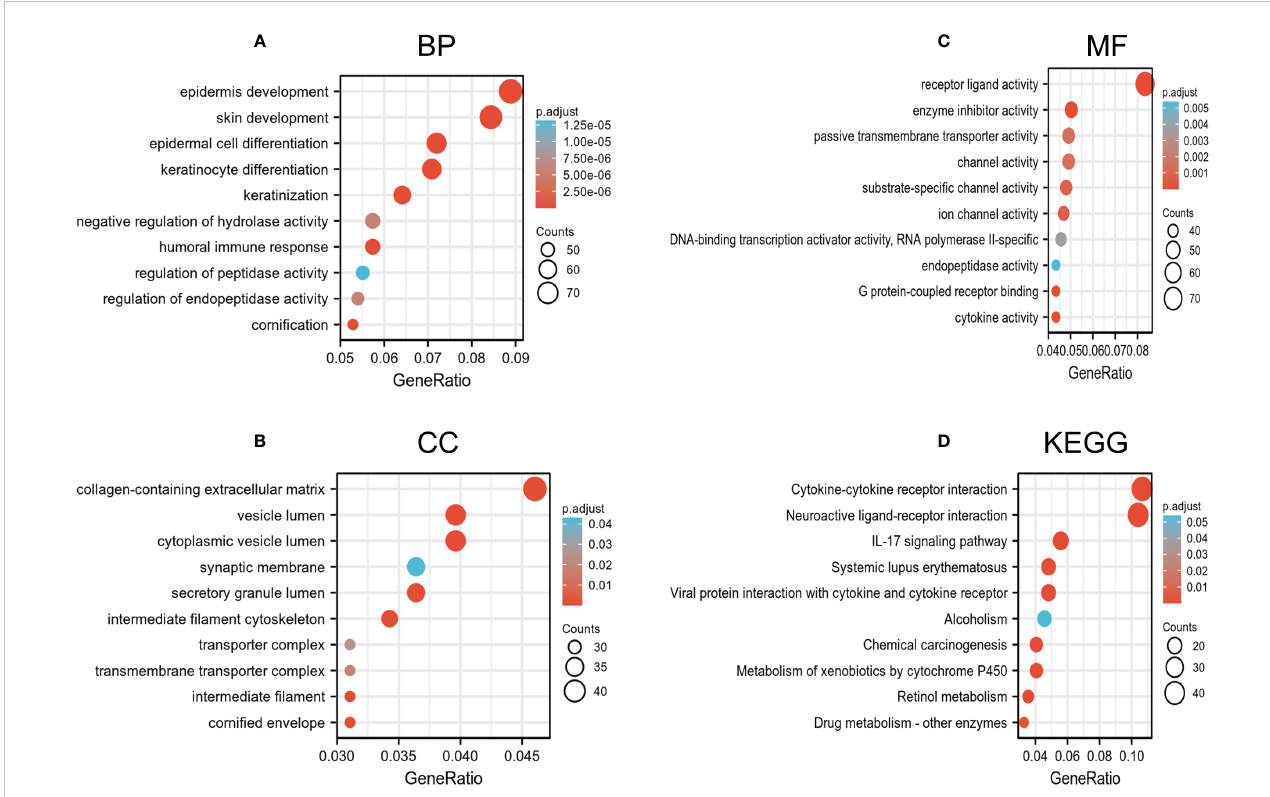
FIGURE 4 Go and KEGG enrichment test of genes associated with HIF1AN in BC cells in the TCGA-BRCA data. (A – C) Go enrichment evaluation revealed the BP (biological processes), CC (cellular components), and MF (molecular function) of co-expressed genes with HIF1AN. (D) substantially enriched KEGG terms derived from KEGG enrichment test of co-expressed genes with